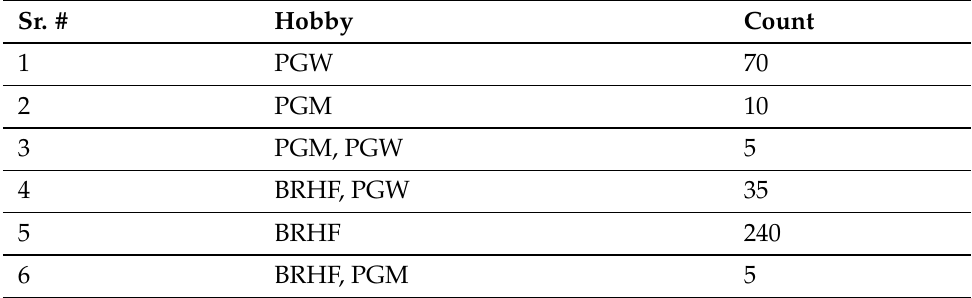
Table 2. Different hobby item sets found in data with eye disorder